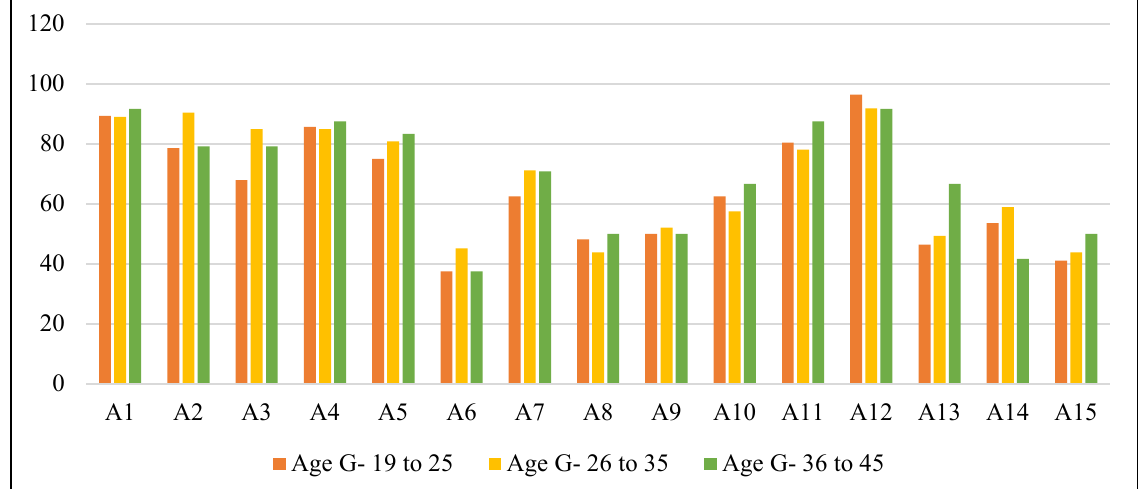
Figure 2 Learners Awareness of the University's e-Services by Age